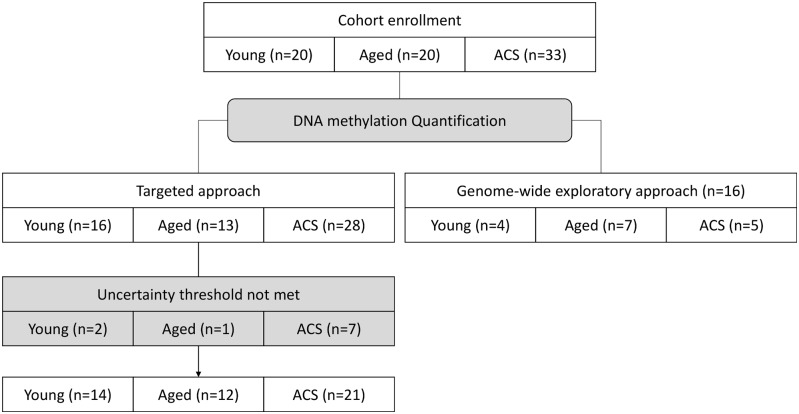
Flowchart illustrating the "n" values between groups throughout the study.